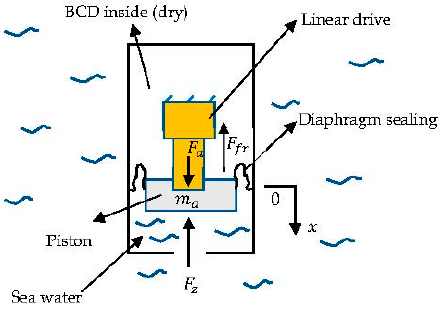
Figure 4. Forces acting on the piston.